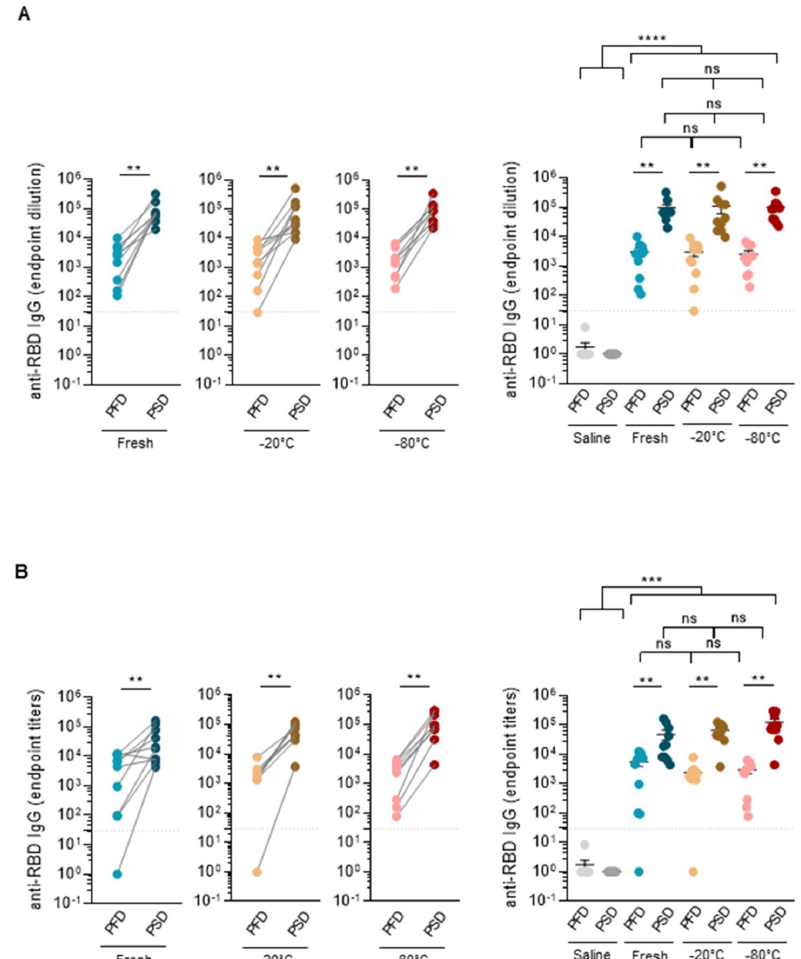
Figure 5. Different handling and re-freezing conditions did not affect the mRNA vaccine immunogenicity. SARS-CoV-2 Spike RBD-specific IgG end-point titers of mice immunized with Comirnaty ® (Pfizer-BioNTech) vaccine ( A ) or Spikevax ® Moderna vaccine ( B ) post-prime and post-boost immunization. Sera from the control mice inoculated with PBS were used to establish negative threshold values defined as the mean plus 4 times the standard deviation of the mean. Bars represent mean ± standard error mean (SEM). Dashed line indicates negative threshold. Data are presented as individual dots. Wilcoxon matched pairs test was performed to compare time points (post the first Dose, PFD; post the second dose, PSD). Two-tailed Mann–Whitney U test was performed to compare vaccine treatments (fresh, −20 °C and −80 °C) (ns = not significant, ** p < 0.01, *** p < 0.001 and **** p < 0.0001). For each time point and condition, n = 10 mice (5 males, 5 females).